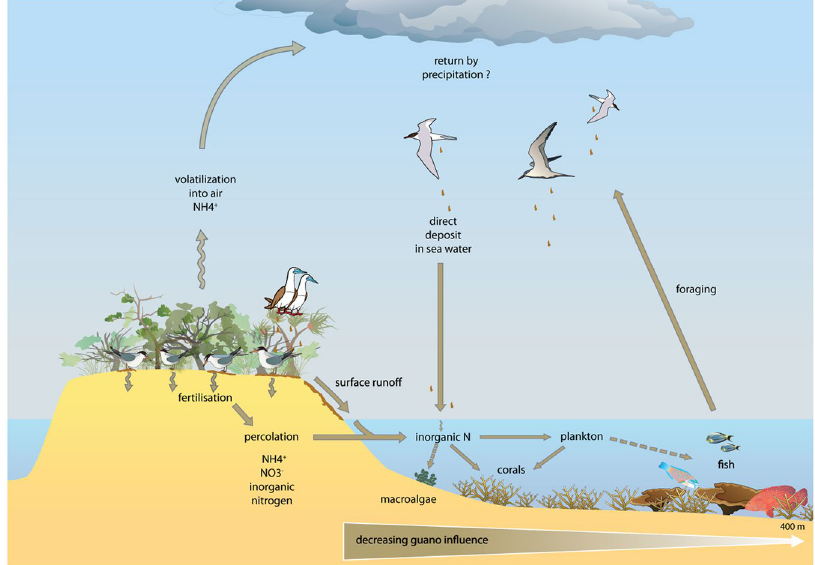
Figure 5. Conceptual diagram showing the different pathways for guano-derived nitrogen to enter seawater and marine food webs (brown arrows) with hypothetical transfers to fish and macroalgae in broken lines, generated with Adobe illustrator CS3 (version 13,